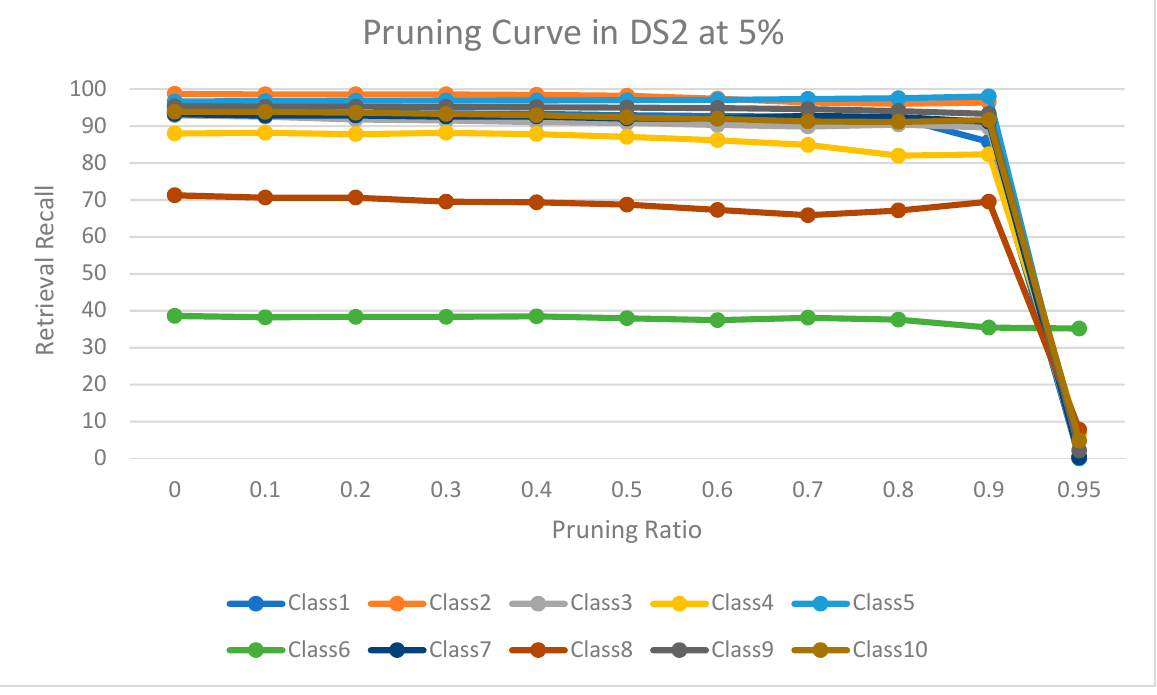
Figure 7. the level of retrieval recall values at different percentages of pruning at the top 5% in MDDR-DR2.